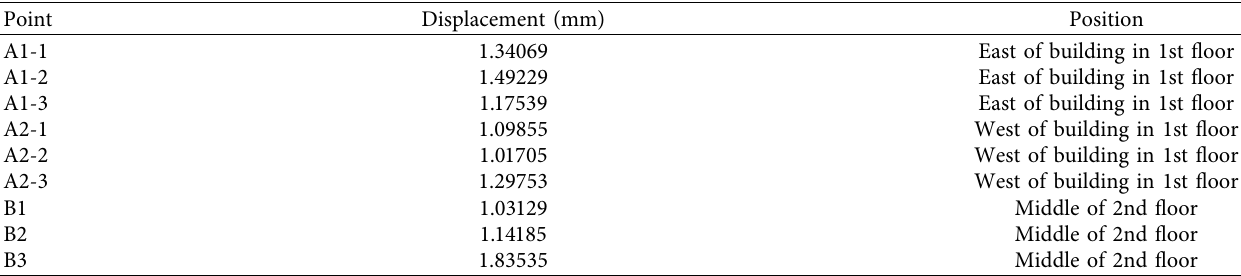
Figure 4: Te design of grouting hole and measure points. (a) Lift curve of each monitoring point. (b) Displacement of grouting point. Table 5: Measurement point location and displacement settlement.